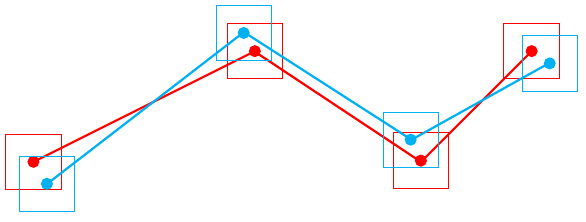
Figure 6. An example of two geometrically matched LineStrings considering error tolerances.